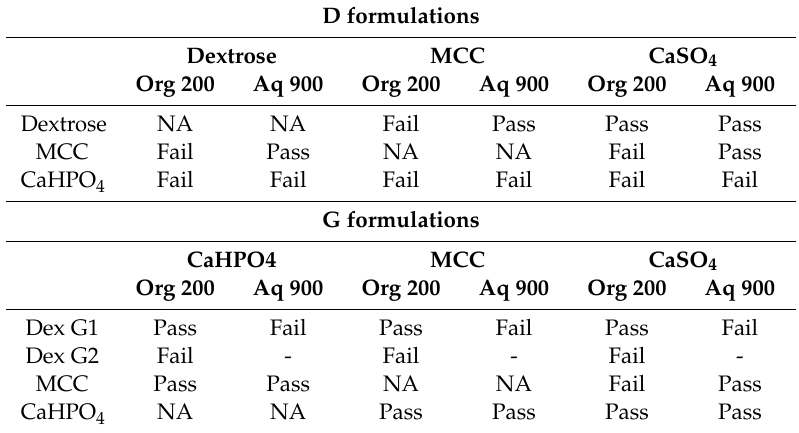
Table 2. Statistical evaluation for the 90% confidence interval between different formulation compositions. D